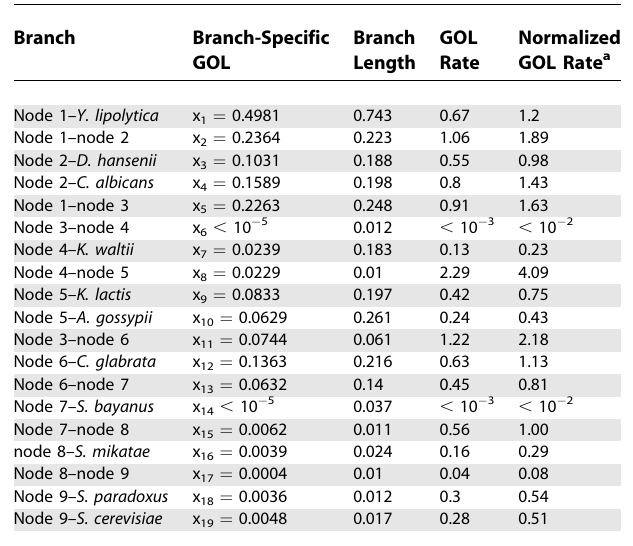
Table 2. Branch-Specific Rates of